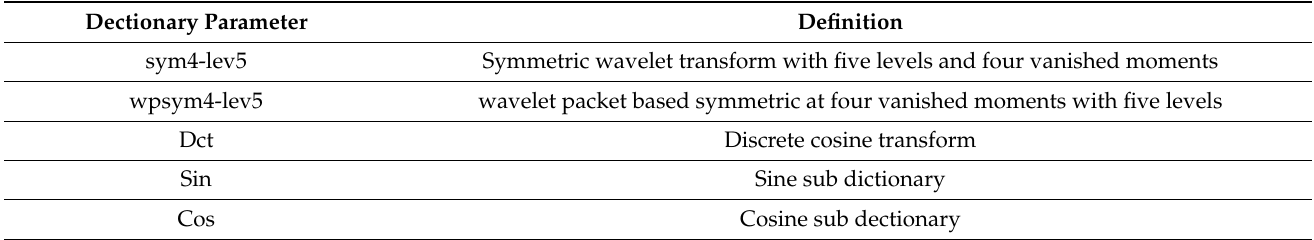
Table 2. Orthogonal Matching Pursuit (OMP) components